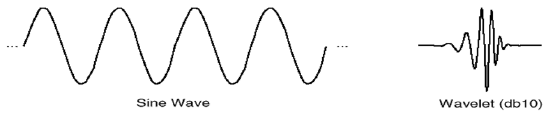
scale parameter. →